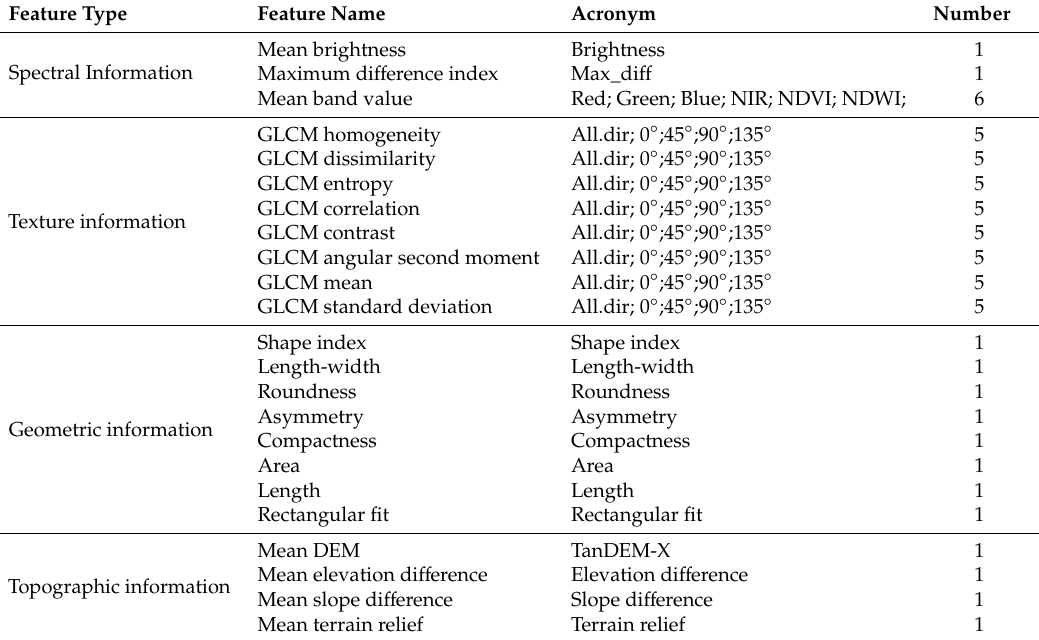
Table 1. Overview of features used in mineral area